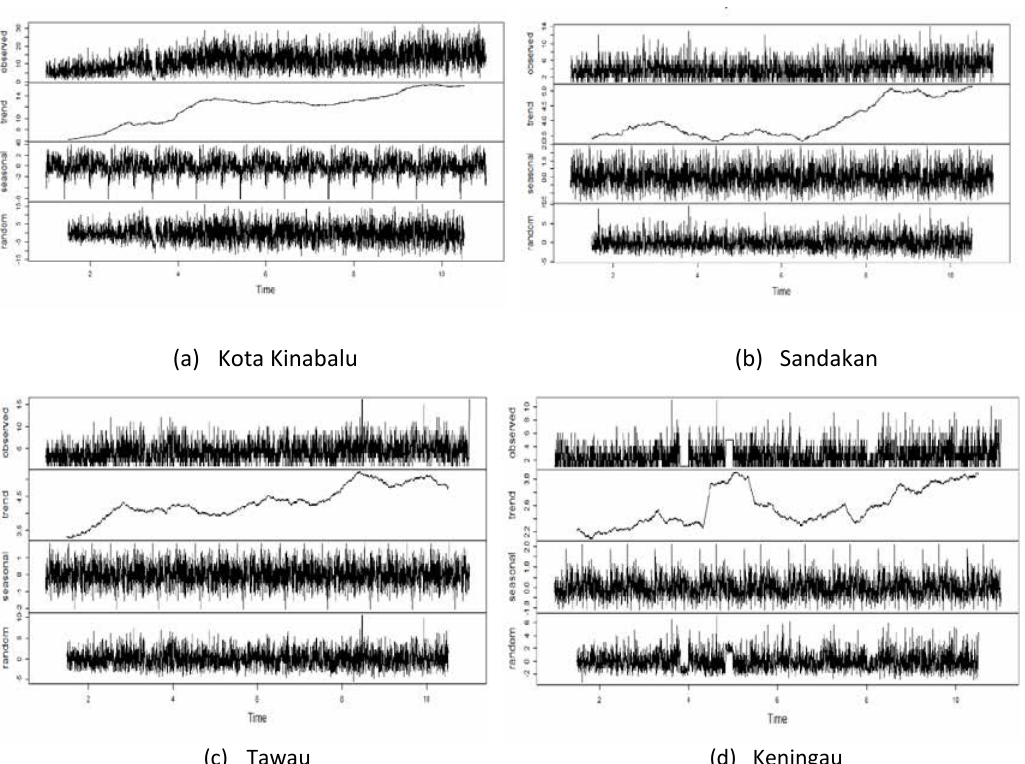
Fig. 2: Decomposition additive time series of CVD hospital admission